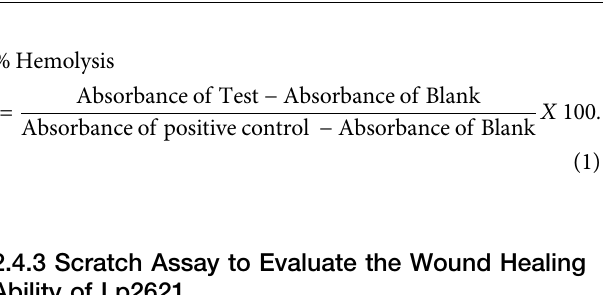
Frontiers in Pharmacology |